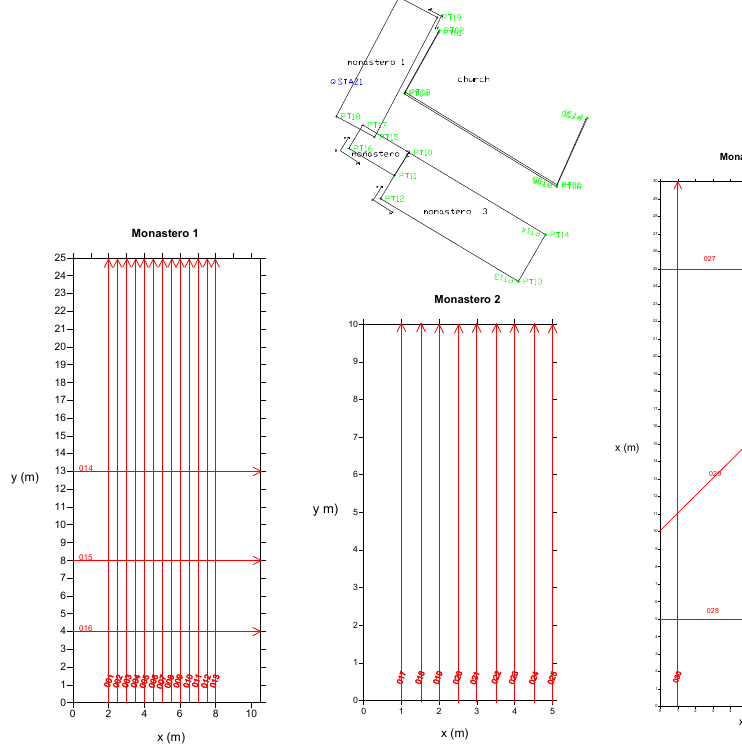
Fig. 3. Magnetic and GPR survey design used in “Monastero” site.